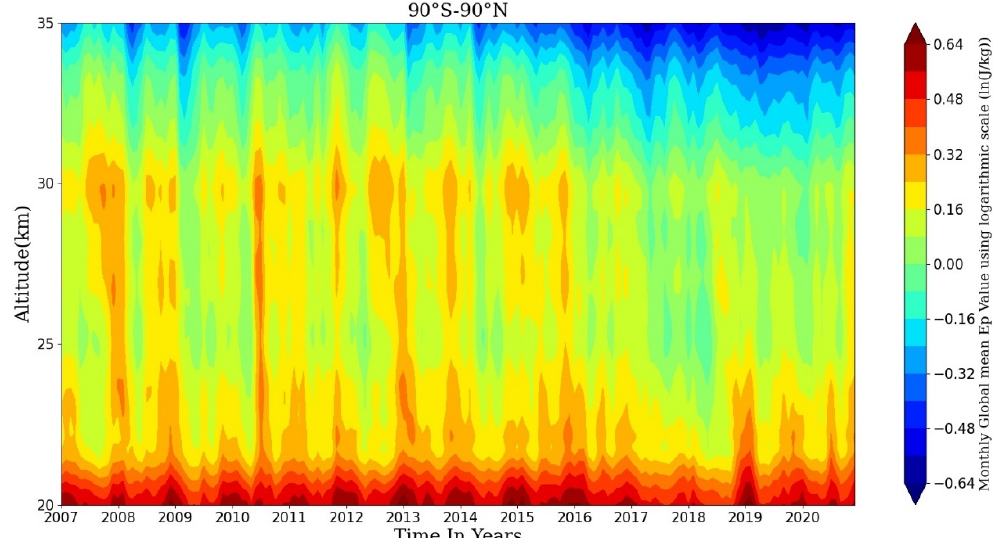
Figure 6. Time–altitude distribution of the monthly and global-mean GW Ep at 20–35 km during 2007 to 2020. Logarithmic scale is used.